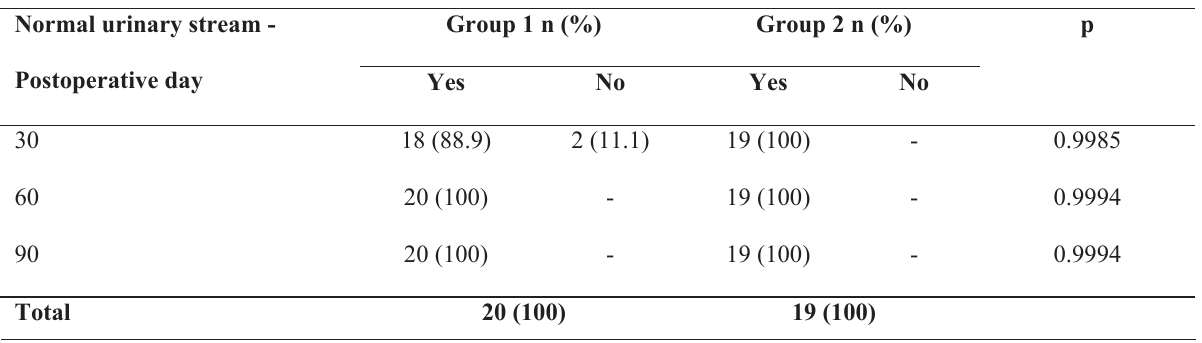
Table 2 – Postoperative spontaneous void after sling surgery for the treatment of stress urinary incontinence.